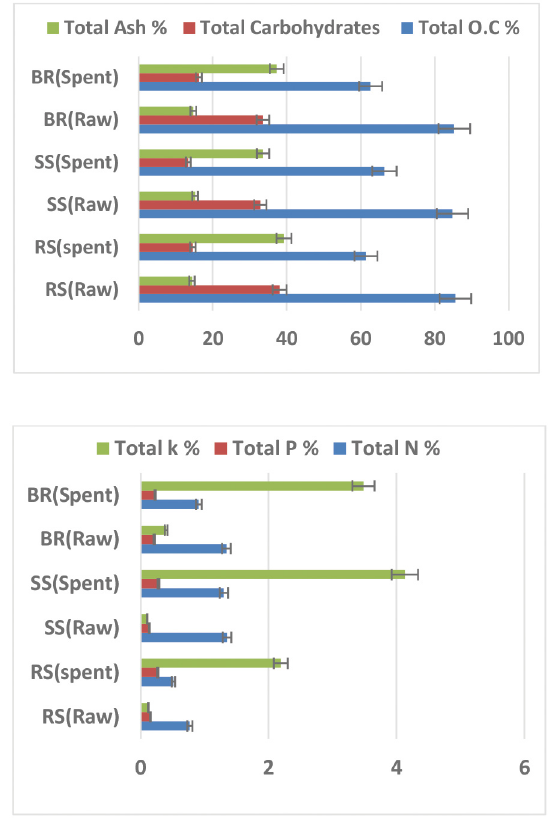
Fig. 6 Total N, P, and k% alteration in substrate materi- als (RS, SS, and BR) before and after oyster mushroom cultivation RS=Rice straw, SS= Sorghum stalks, BR= Banana residues; lines above the columns refer to standard error values (SE); n =